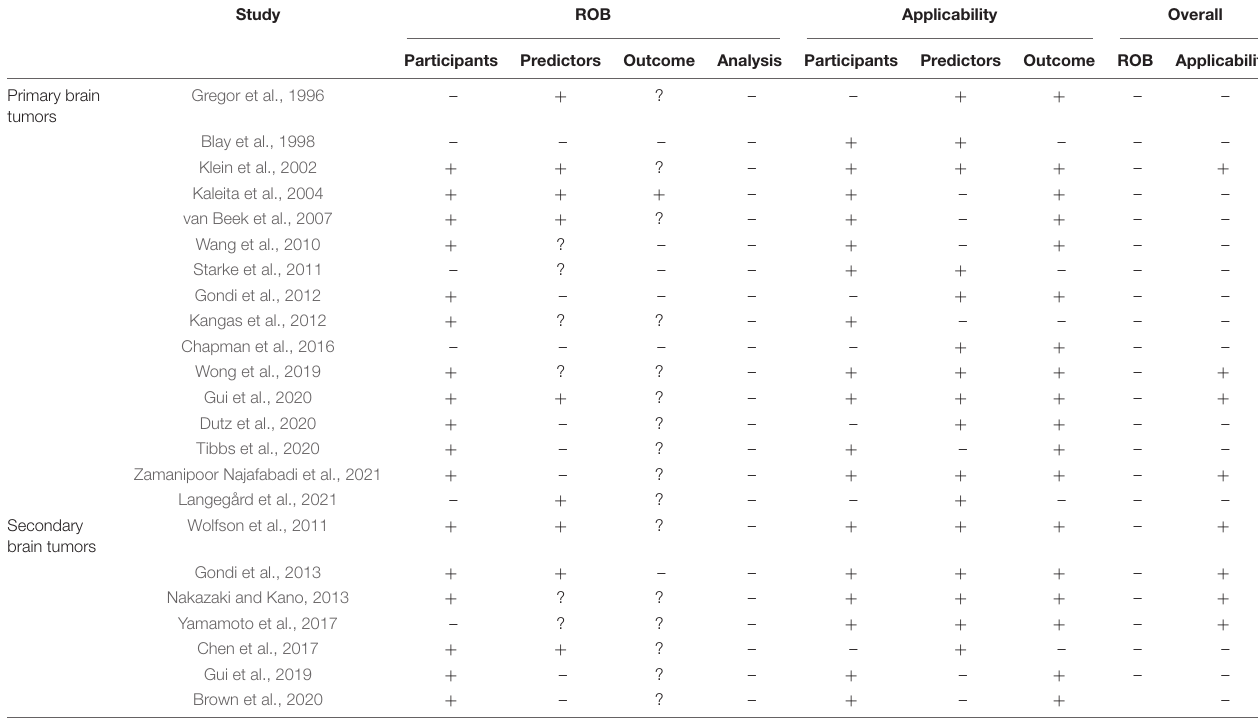
TABLE 2 | Quality assessment for risk of bias and applicability concern of the included prediction